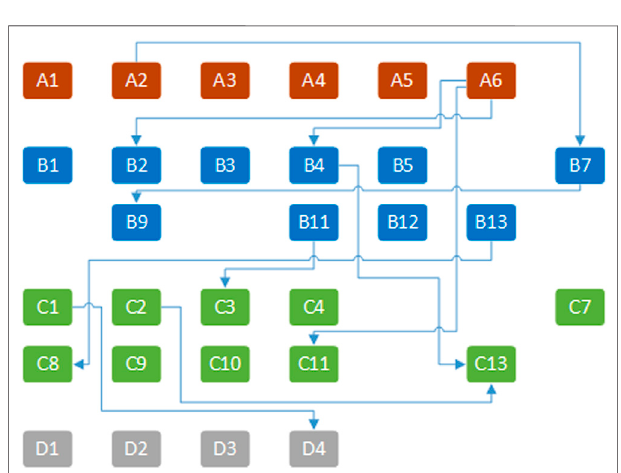
FIGURE 3 | Behavioral transfer diagram for secondary schools.